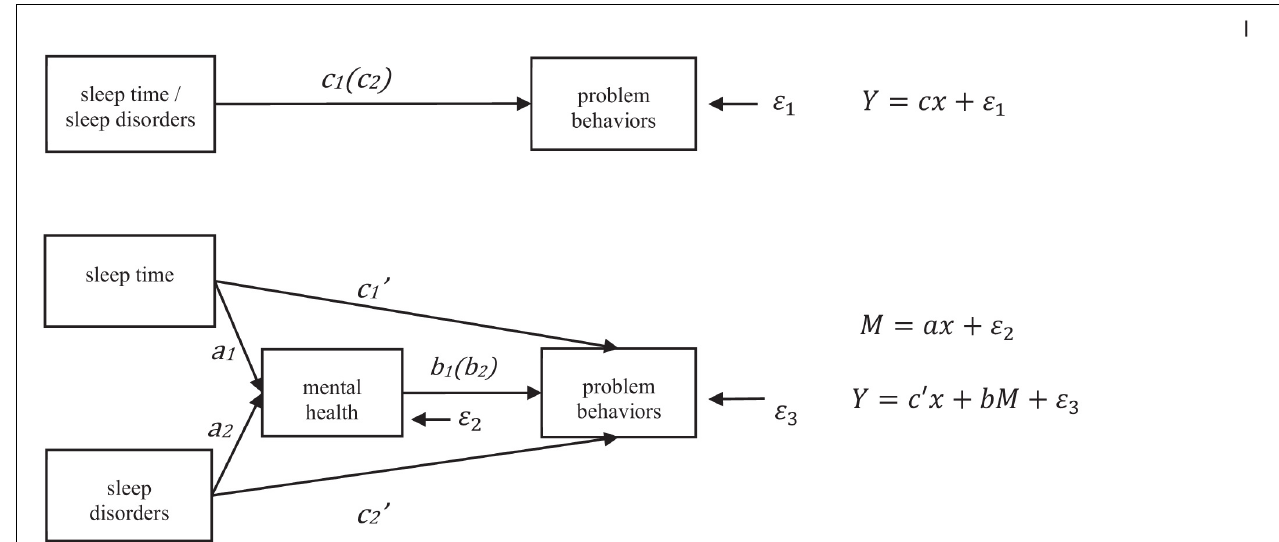
FIGURE 1 | Mediating effect